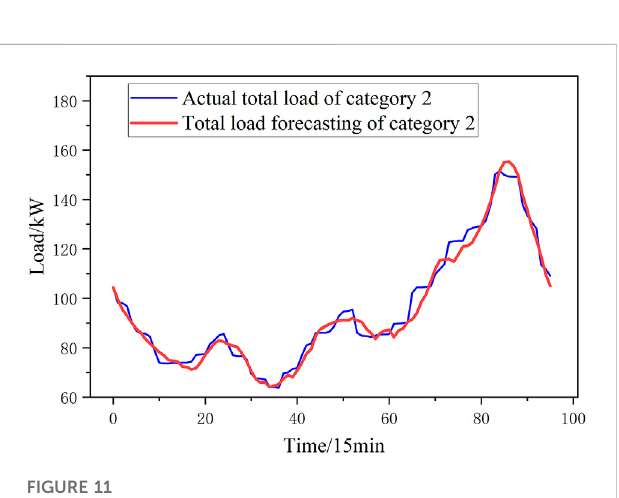
FIGURE 11 Forecasting result of Category